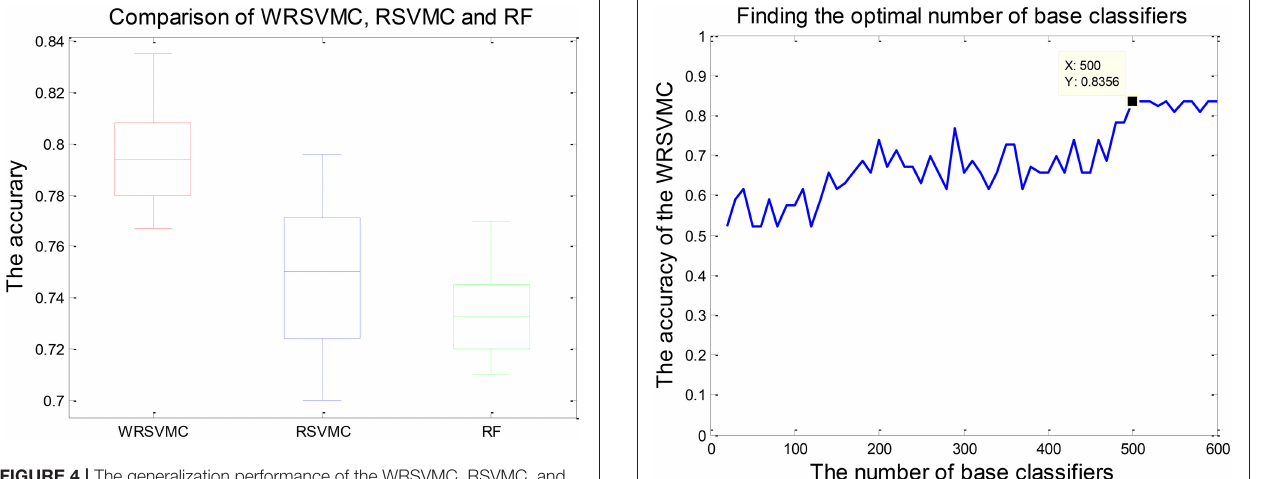
FIGURE 4 | The generalization performance of the WRSVMC, RSVMC, and RF. TABLE 1 | The statistical significance of results between the algorithms.